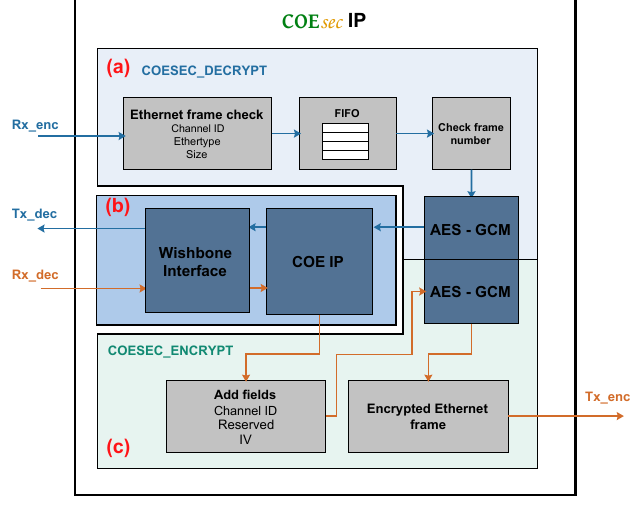
Figure 4. Block diagram of the COEsec architecture implementation. ( a ) Module for reception, validation, and decryption of COEsec frames. ( b ) Module to establish communication between the COEsec and the IP core, all through bus Wishbone. ( c ) Module to generate, encrypt and transmit COEsec